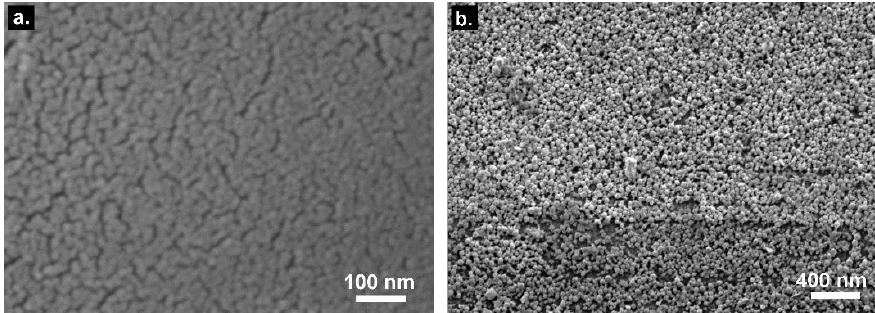
Figure 4. ( a ) SEM picture of a sputter-coated optical fiber surface (1 × 50 nm Au). ( b ) SEM picture of an electroless-plated (ELP) optical fiber surface.